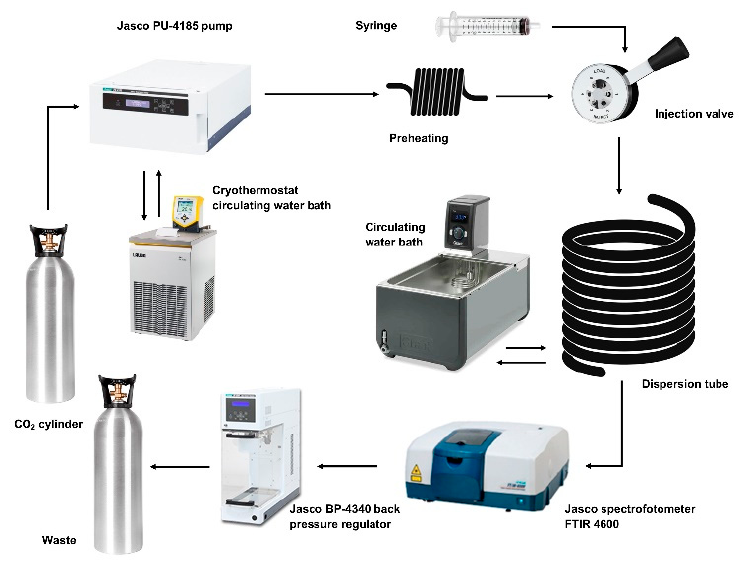
Figure 1. Schematic representation of high-pressure Taylor dispersion set-up.